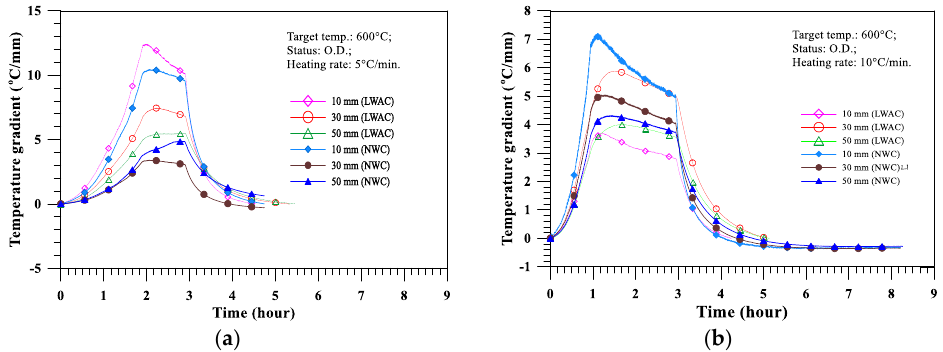
Figure 11. Comparison of the temperature gradients between the LWAC and NWC oven-dried specimens at a target temperature of 600 °C: ( a ) heating rate of 5 °C/min; ( b ) heating rate of 10 °C/min.